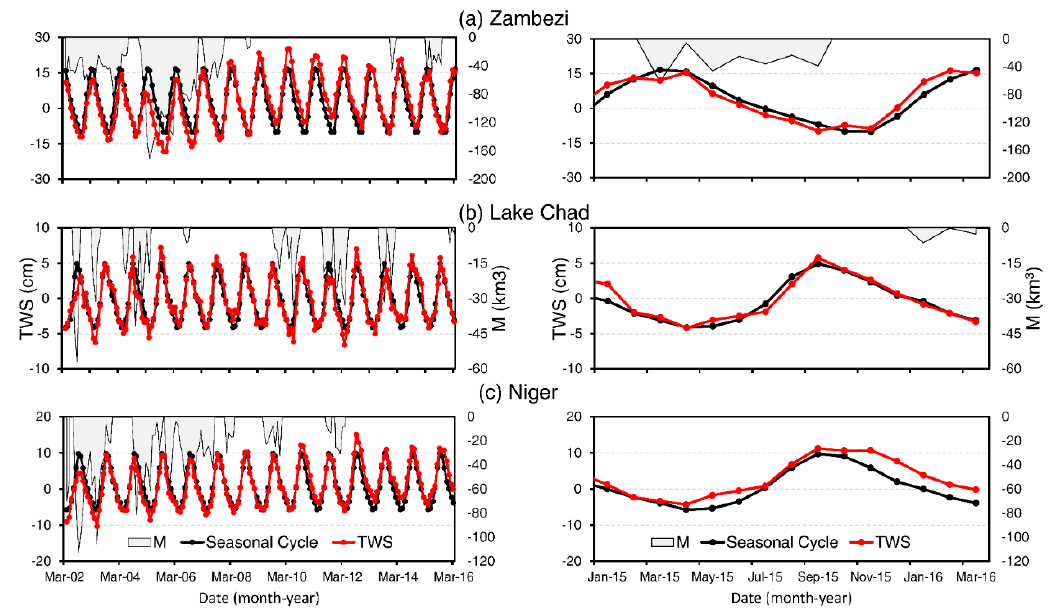
Figure 6. Terrestrial water storage (TWS) anomalies (red line; cm), seasonal cycle (black line; cm) and deficits ( M ; gray shaded areas; km 3 ) for the ( a ) Zambezi, ( b ) Lake Chad, and ( c ) Niger basins. Left panel shows the entire period (April 2002–March 2016) and right panel shows the forecasting period (October 2015–March 2016).